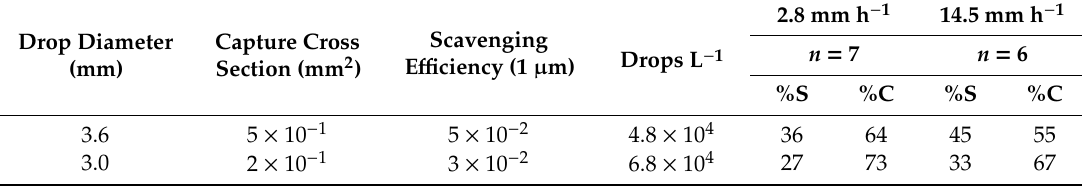
Table 2. Effect of drop size and rain intensity on cell scavenging. The proportion of cells in Louisiana rain samples that were scavenged below-cloud (%S) or originated from the cloud (%C) were estimated using the scavenging efficiencies in Figure 4. Rain data are from [29].